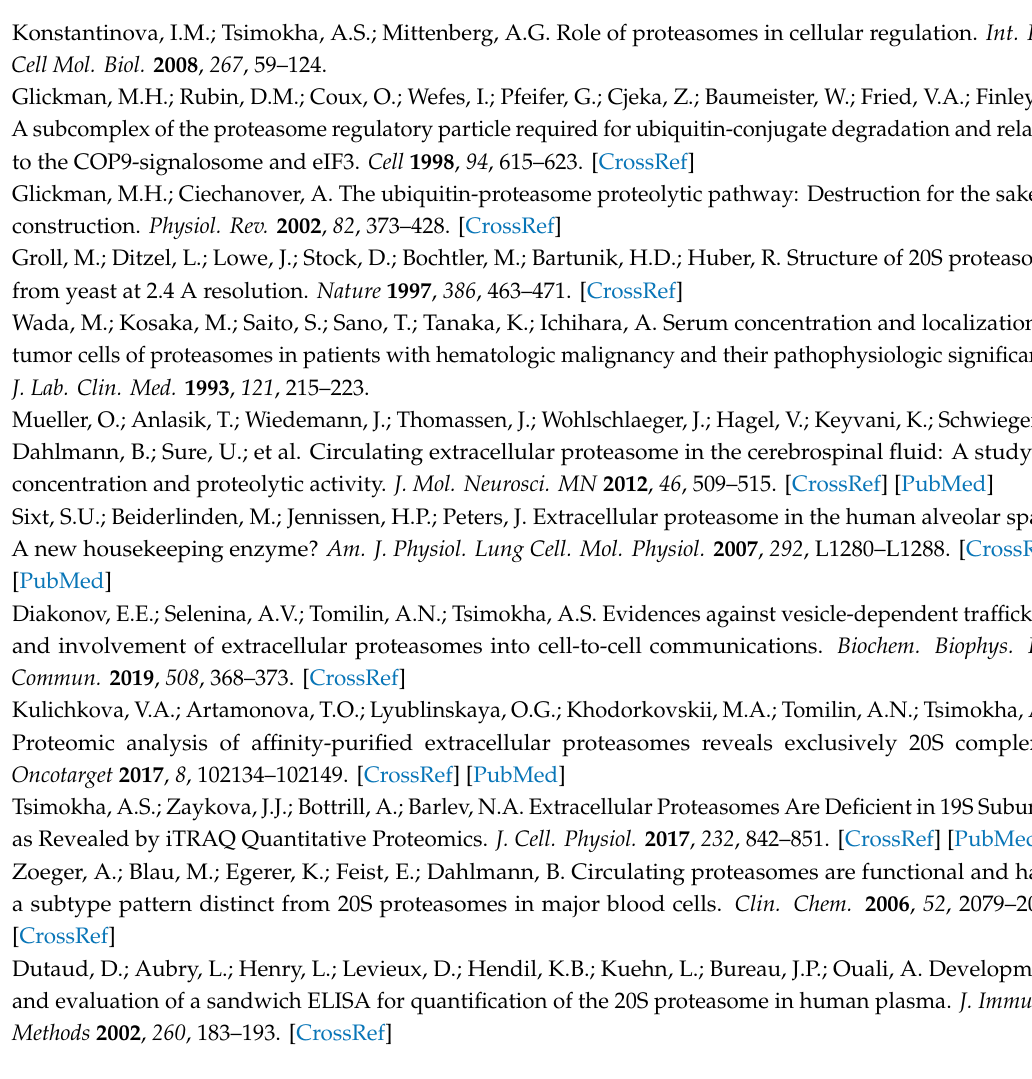
Table S1: The data of MALDI FT-ICR MS analysis of cellular and extracellular proteasomes, Table S2: The results of MALDI FT-ICR MS analysis of cellular and extracellular proteasomes, Table S3: Potential modifications of cellular and extracellular proteasomes identified by MALDI FT-ICR